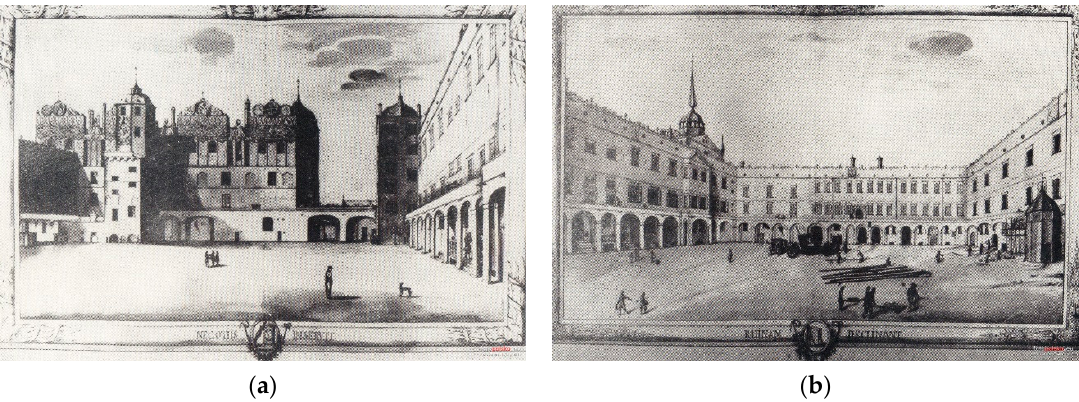
Figure 7. ( a ) Jan Joachim Zeuner, main courtyard in 1673, source: fotopolska.eu; ( b ) Jan Joachim Zeuner, main courtyard in 1673, source: fotopolska.eu.